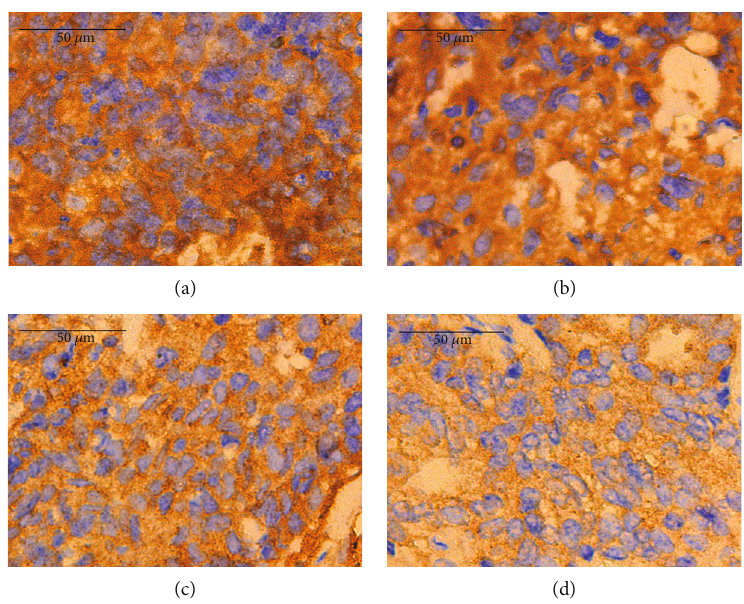
Figure 4: Immunohistochemistry for VEGF in di ff erent groups ( × 400). (a) A large number of brown granules were di ff usely distributed in the cytoplasm of tumor cells in the M group, and the VEGF IOD was 8629.55. (b) A large number of brown granules were di ff usely distributed in the cytoplasm of tumor cells in the UTMD group, and the VEGF IOD was 8045.29. (c) In the APA group, the brown fl aky granules were distributed in the cytoplasm of tumor cells, and the VEGF IOD was 6986.39. (d) In the APA-U group, the brown granules were scattered in the cytoplasm of tumor cells, and the VEGF IOD was